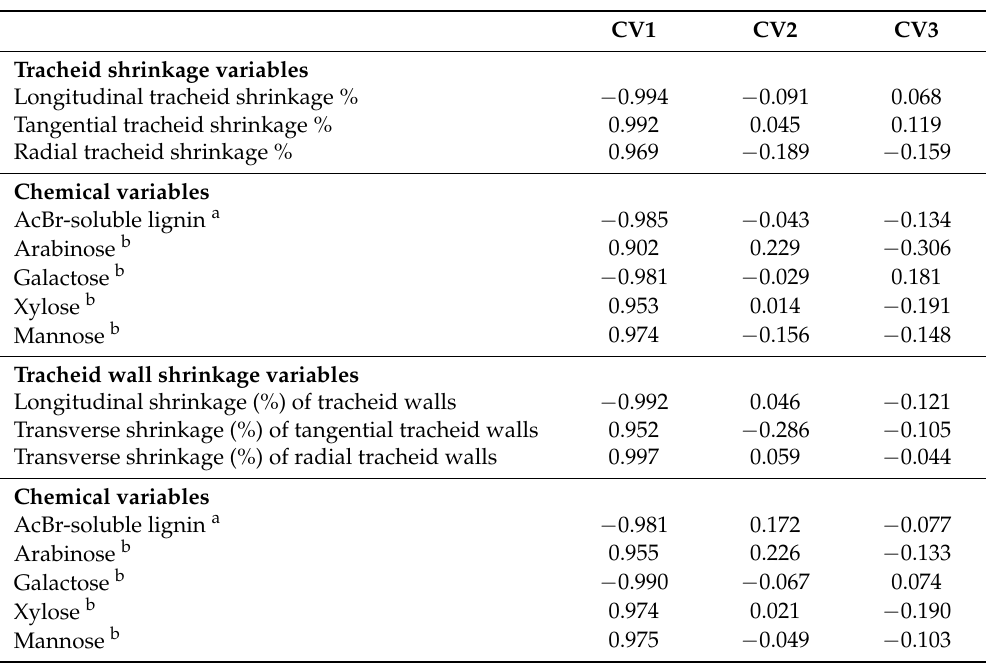
Table 3. Correlations between the tracheid shrinkage and chemical variables and between the tracheid wall shrinkage and chemistry variables and their canonical